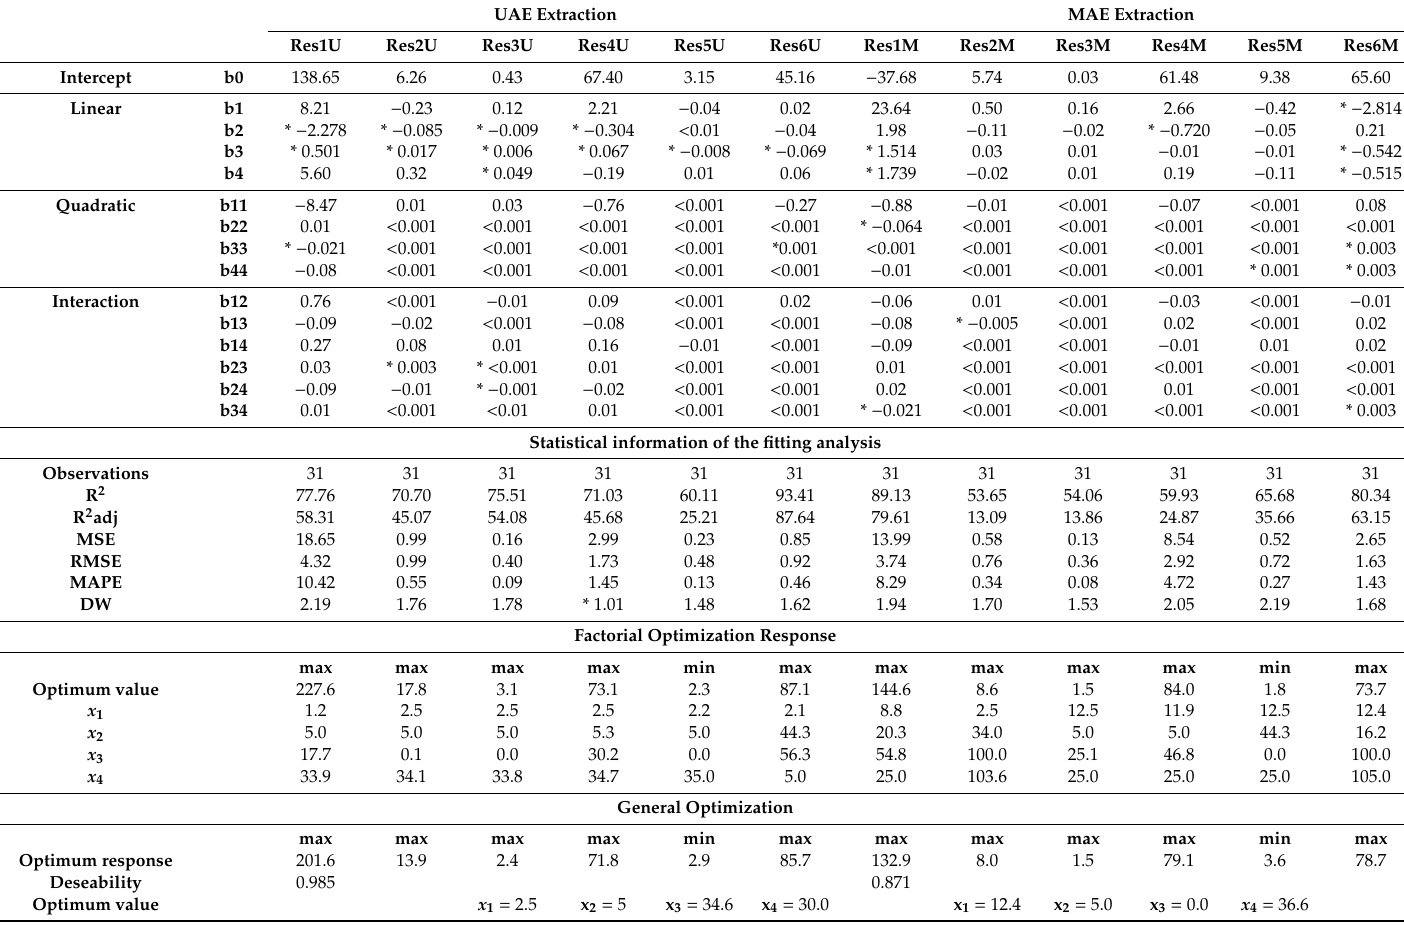
Table 3. Statistical analysis (ANOVA) of the central composite design, including response terms for building the predictive models and optimal response values for the parametric response